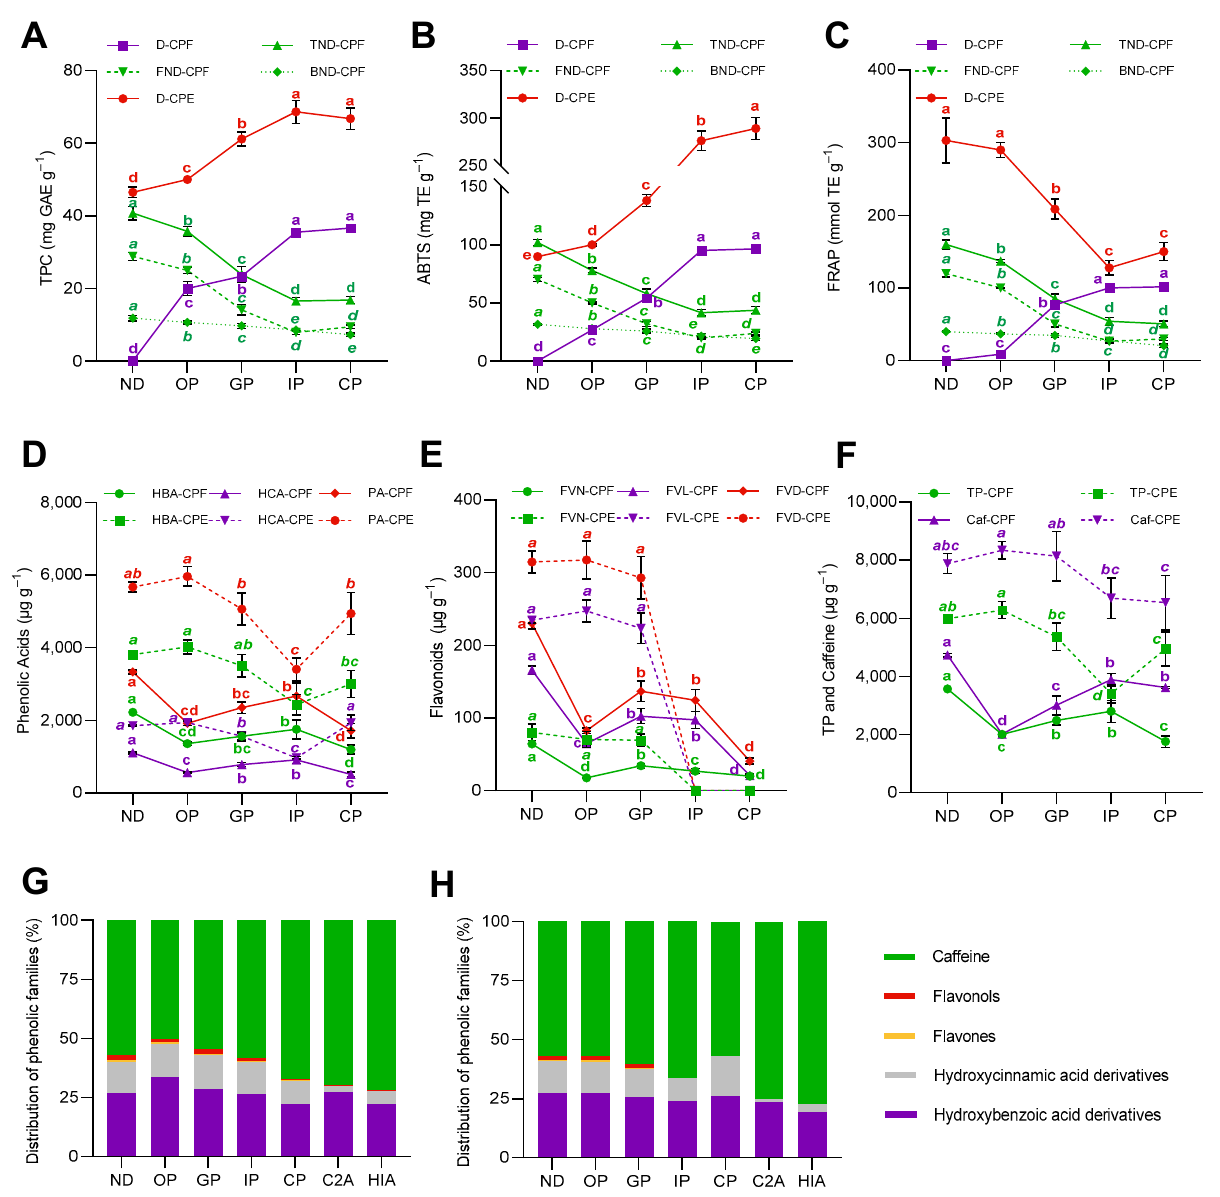
Figure 1. Effect of in vitro digestion of coffee pulp flour (CPF) and coffee pulp extract (CPE) on the total phenolic content ( A ), ABTS ( B ), and FRAP ( C ) antioxidant capacity from the digested (D) and non-digested (ND) coffee pulp, including free (FND), bound (BND), and total (TND) phenolic fractions. Behavior of total phenolic acids (PA) (hydroxybenzoic acids (HBA) + hydroxycinnamic acids (HCA)) ( D ), flavonoids (FVD) (flavones (FVN) + flavonols (FVL)) ( E ), and total phenolics (TP) and caffeine ( F ) throughout the simulated gastrointestinal digestion phases. Distribution of the different phenolic families (flavonols, flavones, hydroxybenzoic acids, and hydroxycinnamic acids) and caffeine in the CPF ( G ) and the CPE ( H ) throughout simulated gastrointestinal digestion. The results are reported as mean ± SD ( n = 3). Points with different letters significantly ( p < 0.05) differ according to ANOVA and Tukey’s multiple range test.